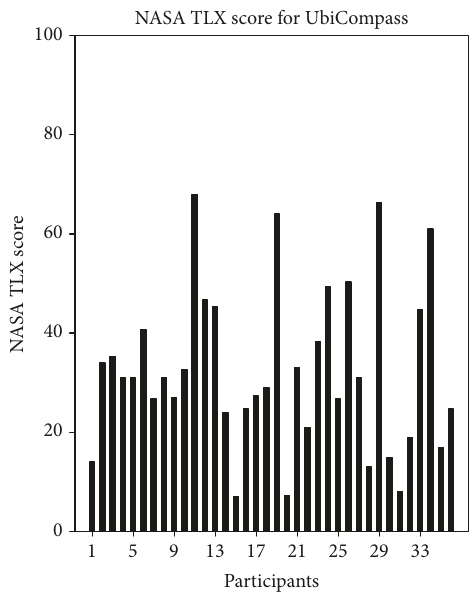
Figure 7: UbiCompass NASA TLX score.